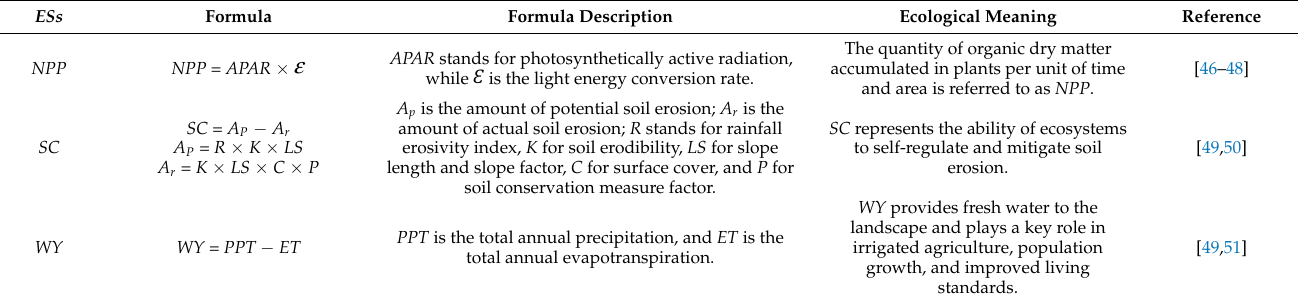
Table 2. The formulas for evaluating ESs.